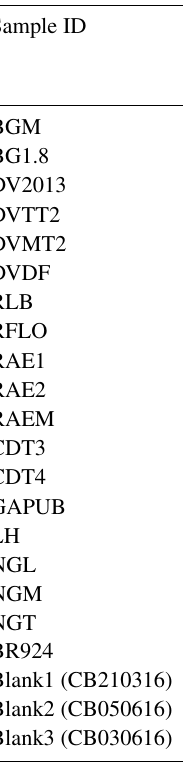
Table A1. Additional CRN sample